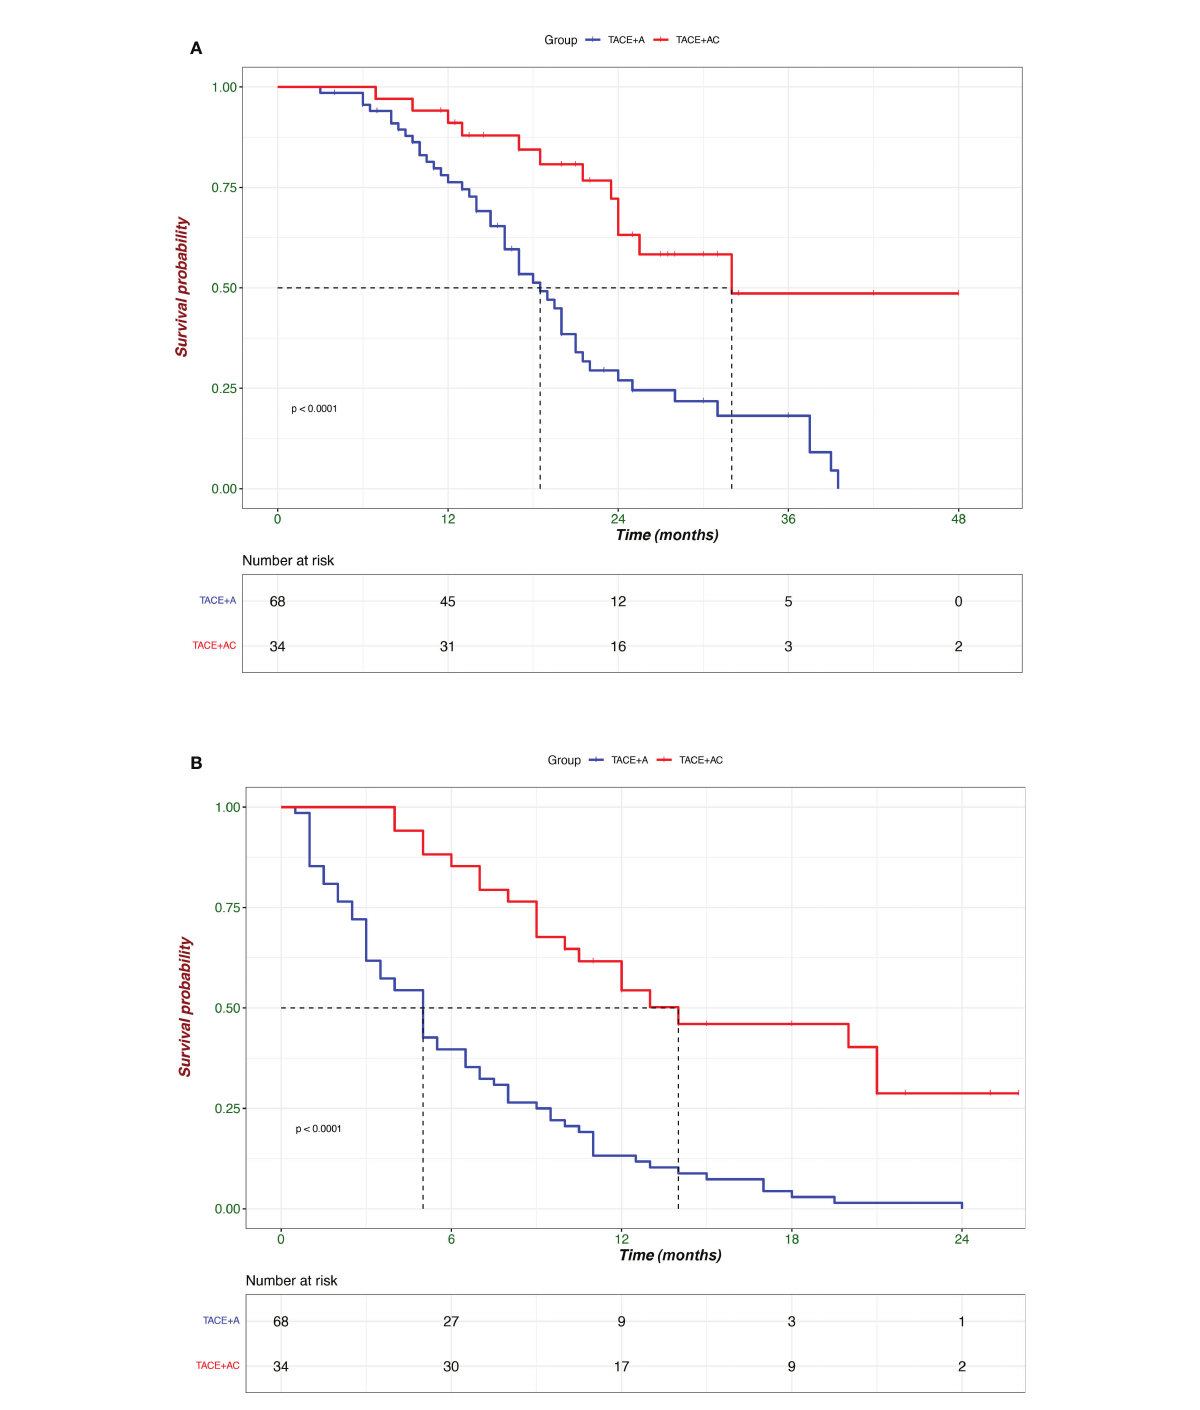
FIGURE 2 Kaplan – Meier analyses of overall survival (A) and progression-free survival (B) according to treatment groups. TACE + A, Transarterial chemoembolization combined with apatinib; TACE + AC, Transarterial chemoembolization combined with apatinib plus